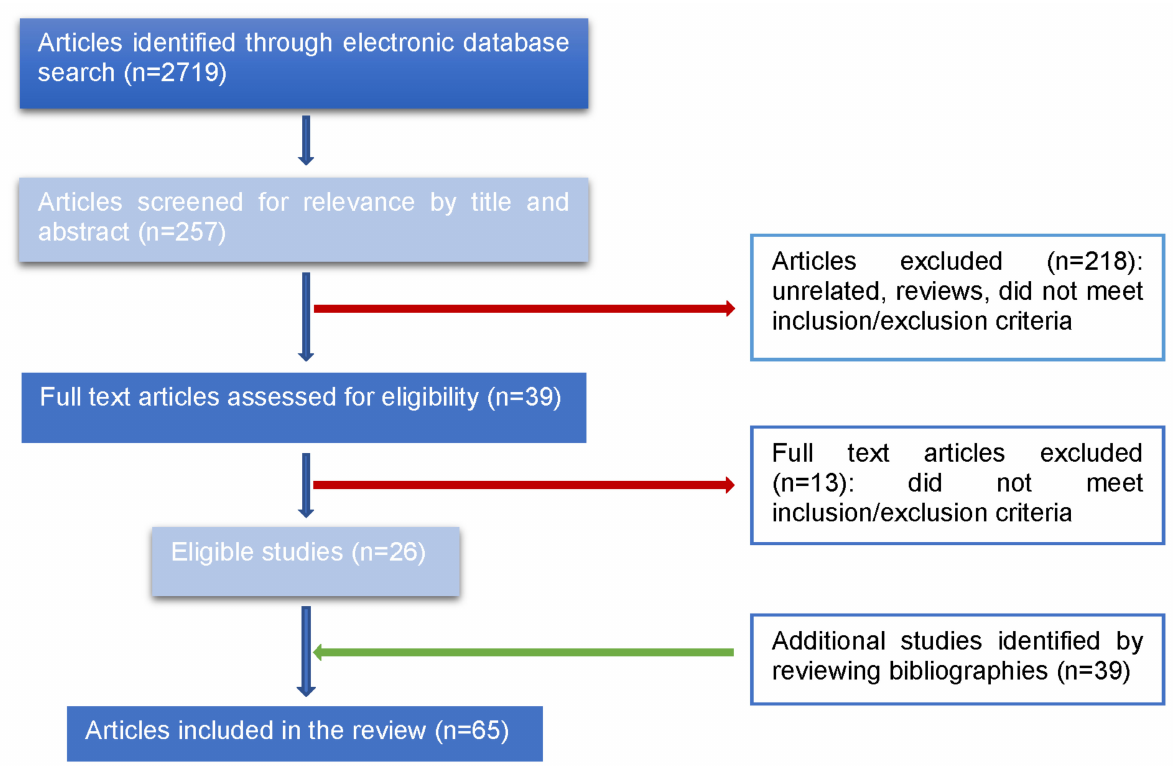
Figure 1. Workflow diagram of the references’ selection process. Bibliography was selected considering different sources of biomarkers including tissue, blood and